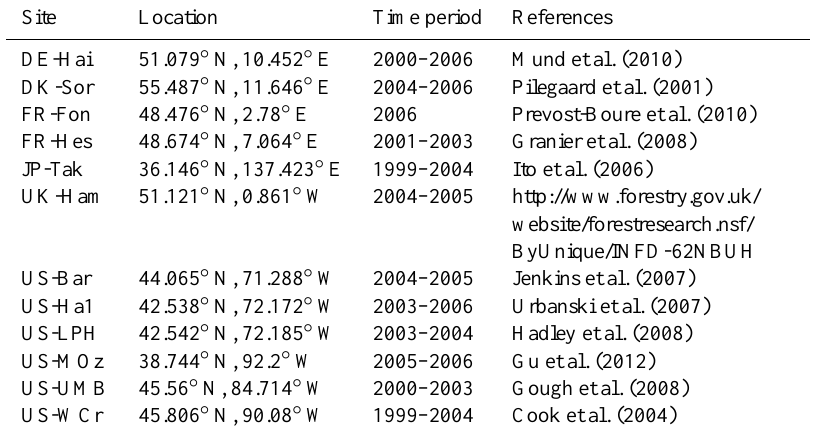
Table A1. Information about the selected FluxNet